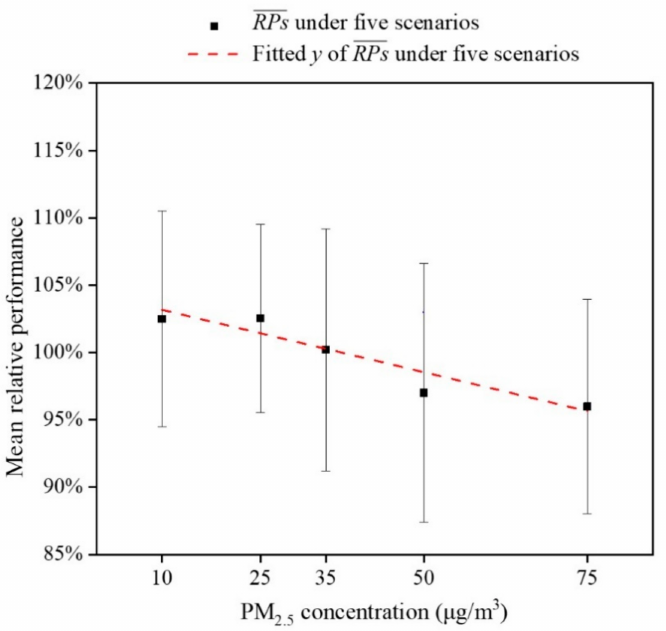
Figure 9. Comparison of the quantitative relationship between relative performance and PM 2.5